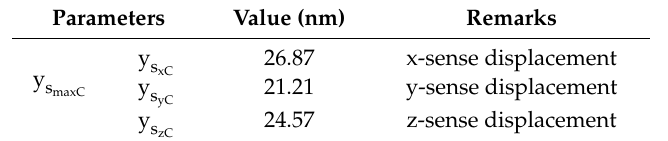
Table 7. Computed sense-displacements of the proposed single-drive, 3-axis MEMS gyroscope.